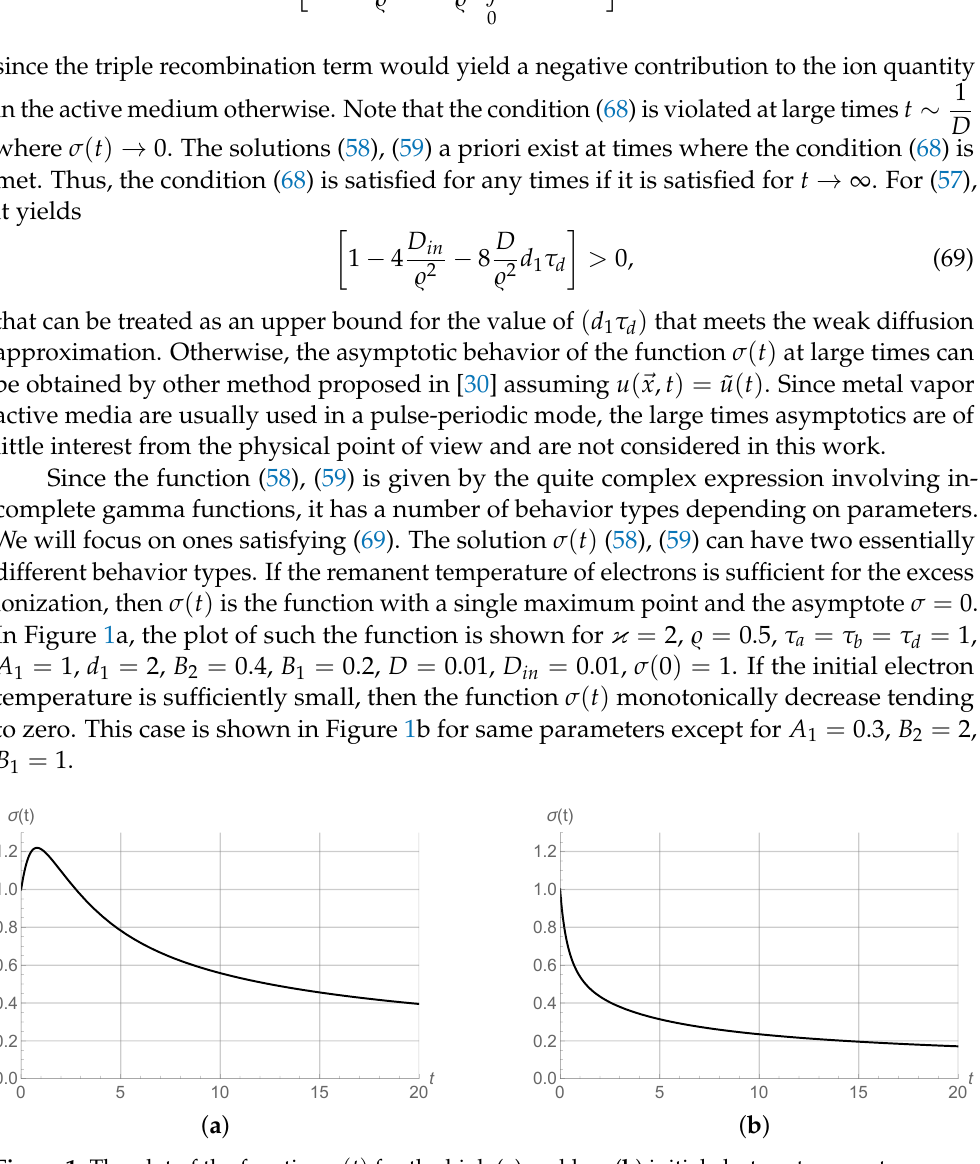
Figure 1. The plot of the function σ ( t ) for the high ( a ) and low ( b ) initial electron temperature. The bifurcation of behavior types is determined by the sign of the number I given by